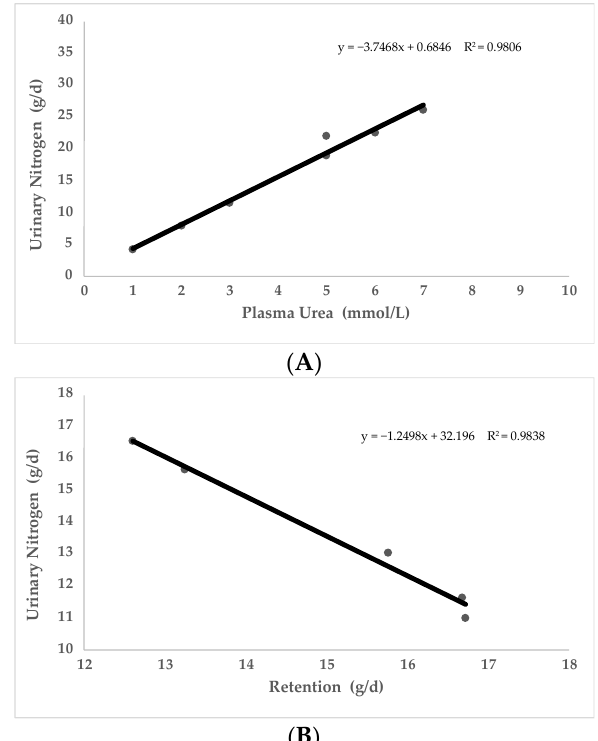
Figure 4. Relationship of plasma urea nitrogen (PUN) with urinary nitrogen excreted ( A ) and rela- tionship of urinary nitrogen excreted with Nitrogen retained ( B ). Data obtained from two published studies in sows and growing pigs [86,71].